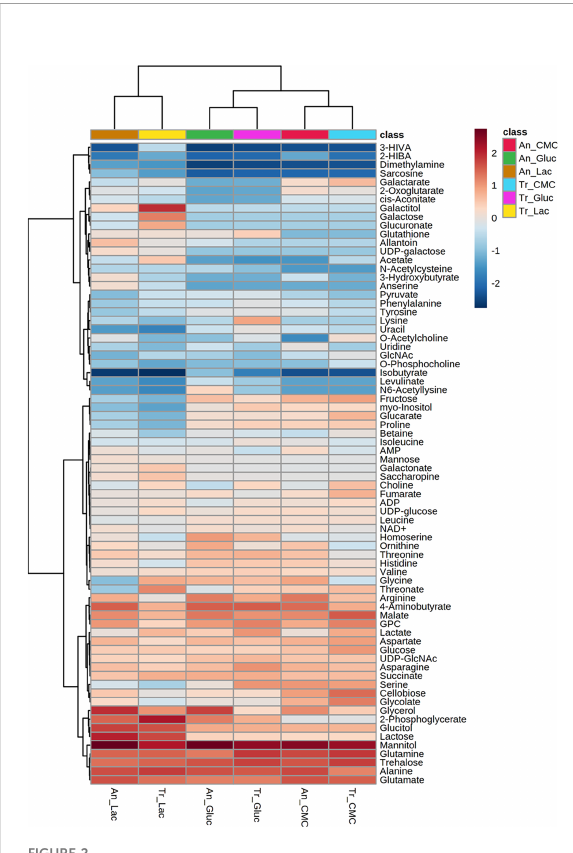
FIGURE 2 Heatmap of metabolites identi fi ed in T. reesei (Tr) and A. niger (An) grown on glucose (Gluc), CMC, and lactose (Lac) for 48 h. The abundance of each metabolite is presented as the normalized values of each condition after hierarchical clustering and scaling according to the carbon sources. 3-HIVA: 3- hydroxyisovalerate; 2-HIBA: 2-hydroxyisobutyrate; GlcNAc: N- acetylglucosamine; GPC: sn-glycero-3-phosphocholine; UDP- GlcNAc: uridine diphosphate